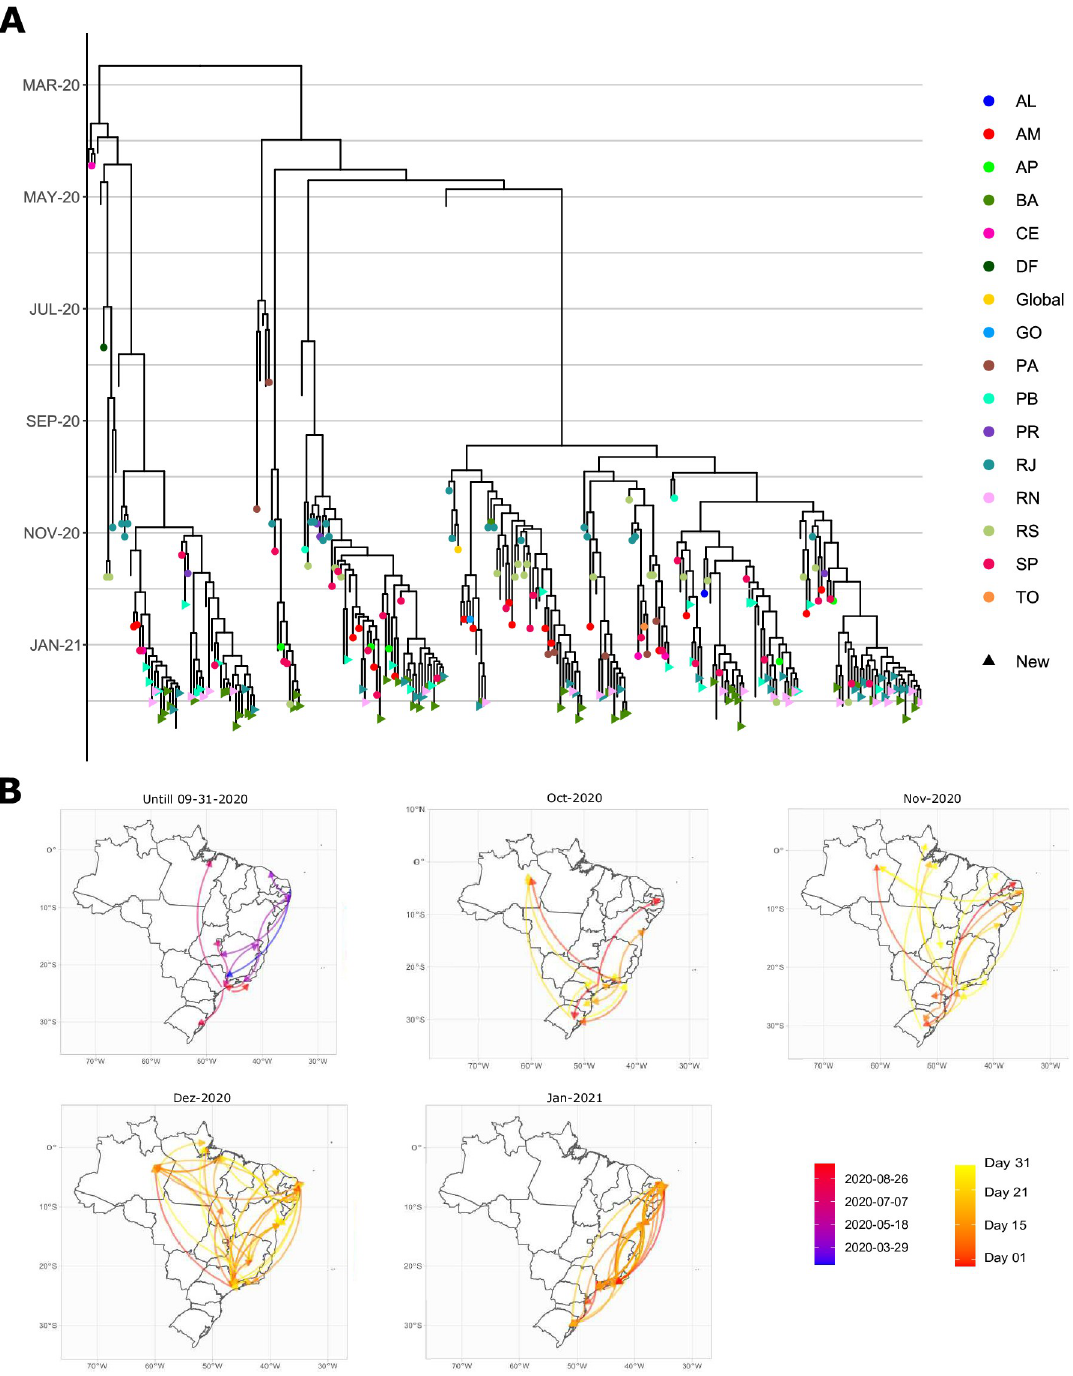
Fig 3. Divergence times within P.2 lineage (A) and its dispersal routes (B) . Colors of tip points in the tree indicate the origin of P.2 samples (AL: Alagoas, AM: Amazonas, AP: Amapa´, BA: Bahia, CE: Ceara´, DF: Distrito Federal, GO: Goia´s, PA: Para´, PB: Paraı´ba, PR: Parana´, RJ: Rio de Janeiro, RN: Rio Grande do Norte, RS: Rio Grande do Sul, SP: S ã o Paulo, TO: Tocantins), while tips without a point are sequences from other lineages. Colors of the arrows in the map indicate the date that each interstate transmission route initiated. Vector and raster map data were obtained from Natural Earth and can be found on https://naturalearth.s3.amazonaws.com/10m_ cultural/ne_10m_admin_1_states_provinces.zip.